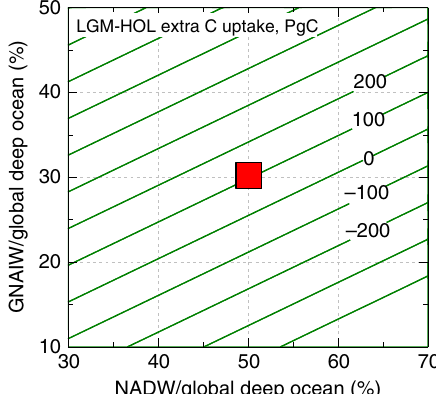
Fig. 6 North Atlantic CO 2 budget. The LGM – Holocene extra carbon uptake is based on Holocene-to-LGM DIC as increase of 91 μ mol/kg. The large red square represents our best estimate of ~100 PgC, assuming that NADW and GNAIW occupied ~50% and ~30% of the global deep ocean (>1 km), respectively 35,36,38,39 . See Methods for calculation